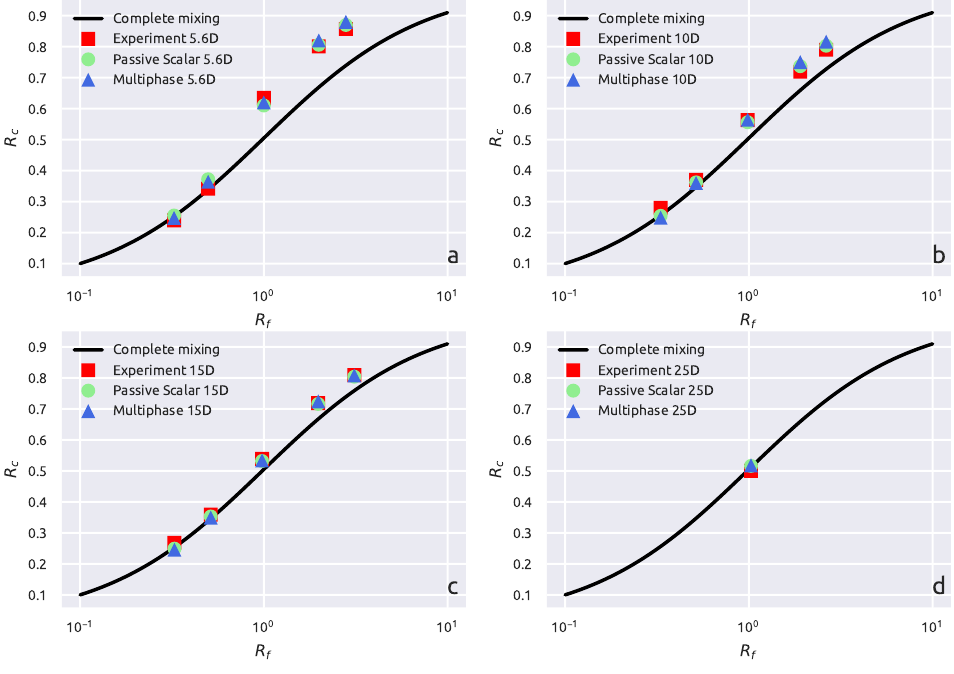
Figure 7. S pipe configuration—comparison of experimental results with passive scalar and multiphase model results for different Tee-junction distances: ( a ) 5.6D, ( b ) 10D, ( c ) 15D, ( d )